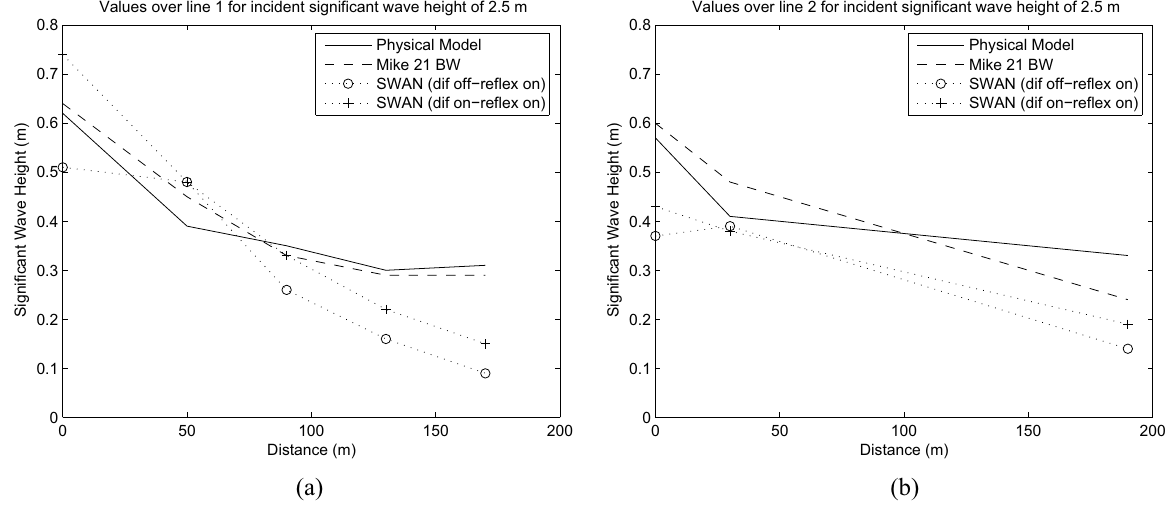
Fig. 6 – Significant wave height measured in the physical model and estimated by the models MIKE 21 BW and SWAN with reflection on for: diffraction off (dif off—reflex on) and diffraction on (dif on—reflex on). For incident significant wave height of 2.5 m (over Line 1 (a) and over Line 2